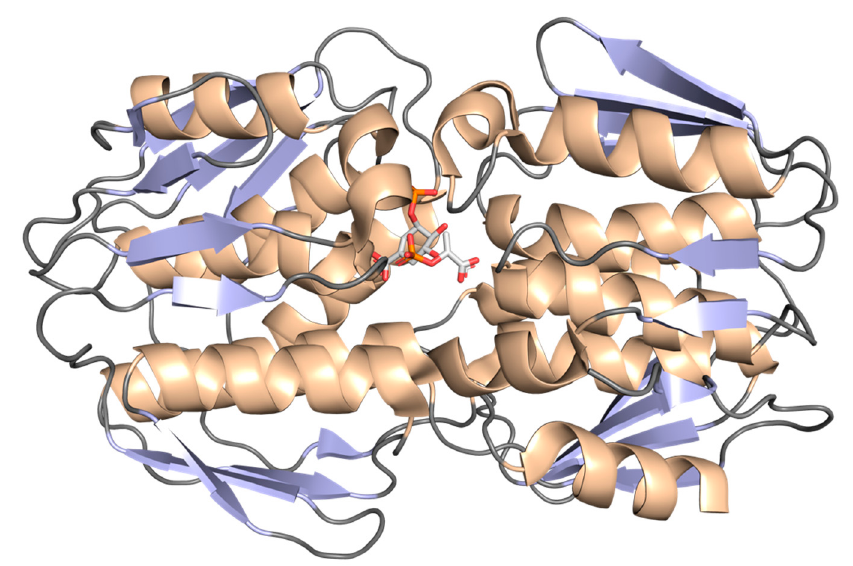
Figure 14. Graphical representation of Mt EPSPS tertiary structure in complex with S3P and PEP. The image was generated on PyMOL.